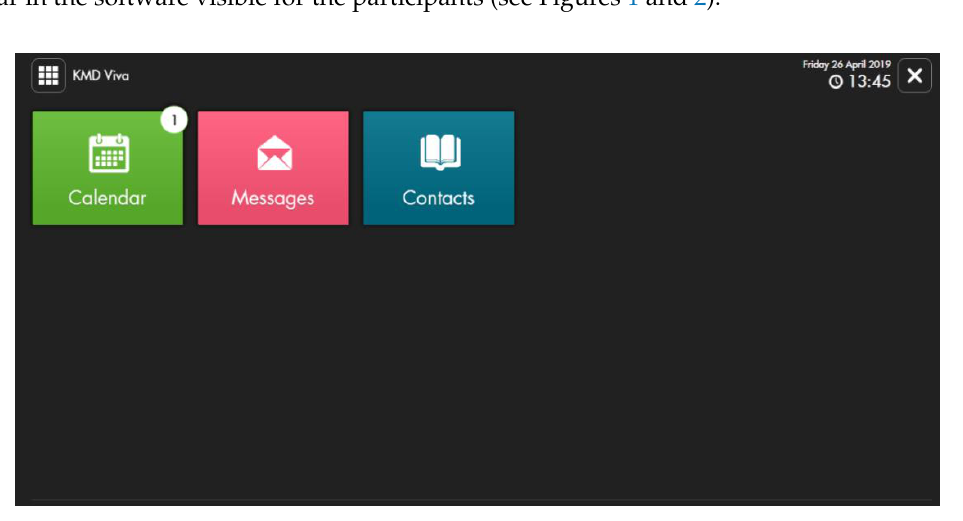
Figure 1. An example of a front screen with different applications; e.g., calendar, messages, and contacts.